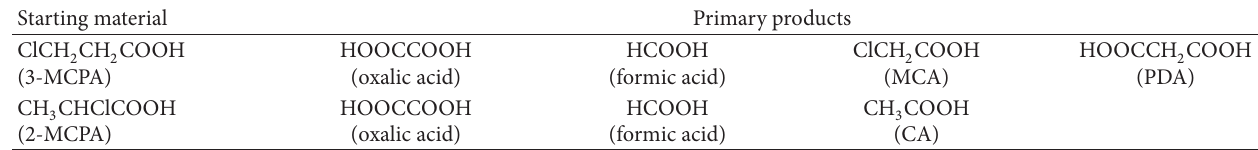
Table 3: Primary products in CGDE of